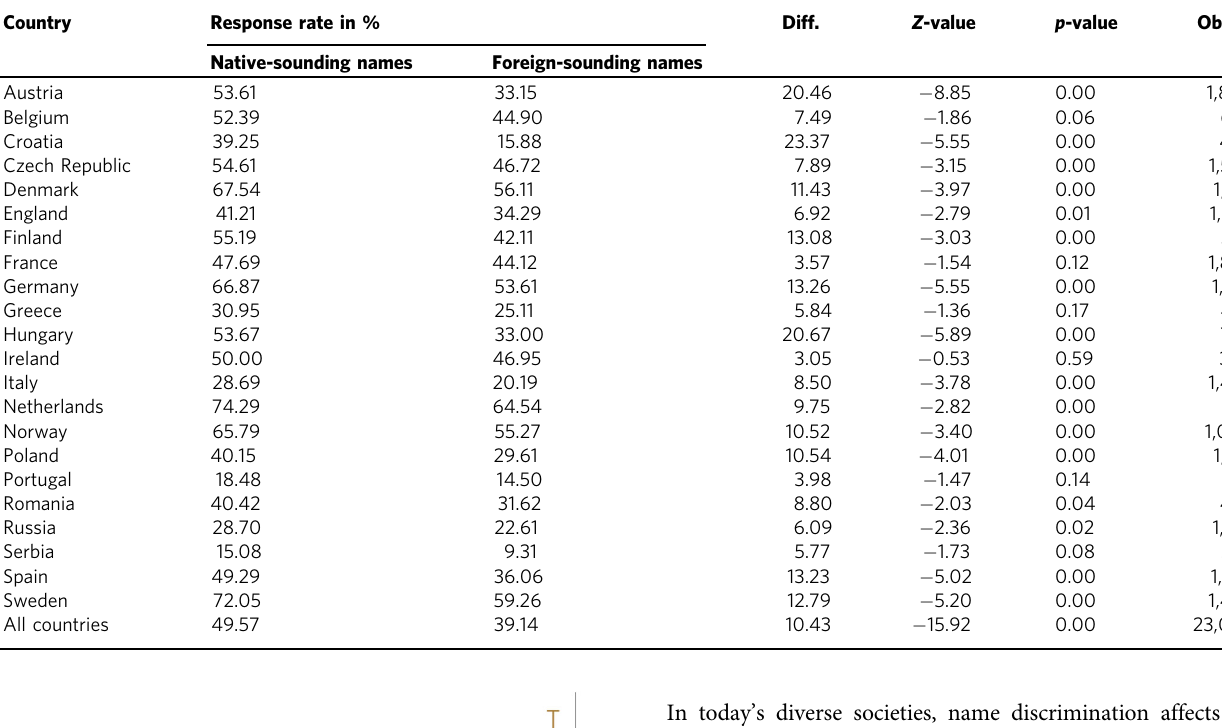
Table 1 Response rate by country (Mann – Whitney test). Country